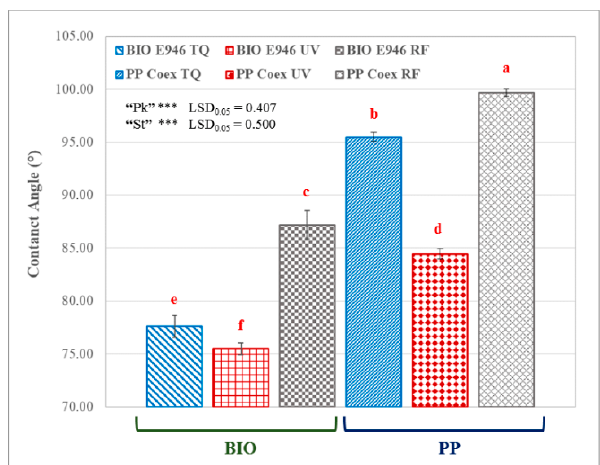
Figure 1. E ff ect of packaging film and sterilization treatment on contact angle. TQ = original sample, UV = UV treated film; and radiofrequency (RF) = RF treated sample. Di ff erent red letters above bars indicate significant di ff erences at p < 0.05 (LSD test). *** Main e ff ects significant at p ≤ 0.001. Error bars are also reported.